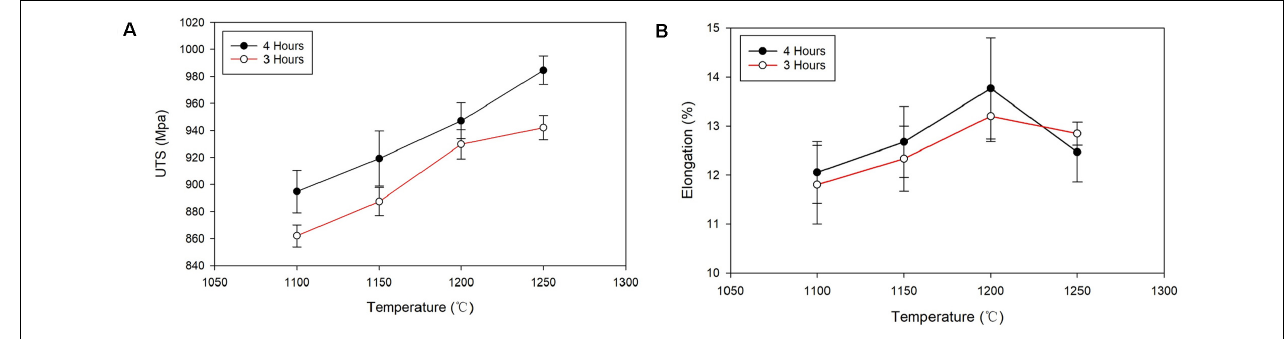
FIGURE 8 | UTS (A) and elongation (B) of sintered